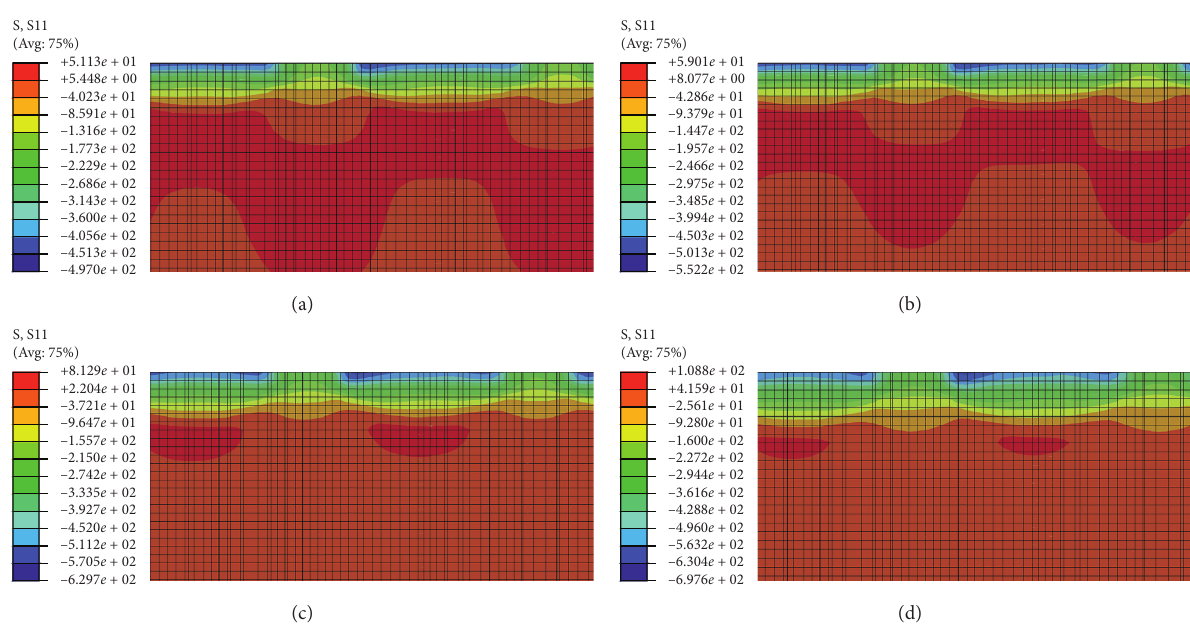
Figure 16: Contours of residual stress distribution of the in-depth direction of sample surface with three different laser energies. (a) 5J, 5J, 5J; (b) 5 J, 5J, 6J; (c) 5J, 6J, 7J; (d) 7J, 7J, 7J.